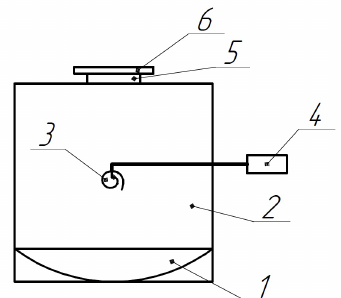
Figure 2. Functional diagram of the laboratory model: 1—elliptical reflector; 2—a support made of polystyrene; 3—ultra-wideband emitter; 4—vector reflectometer; 5—test sample; and 6—sheet of metal.